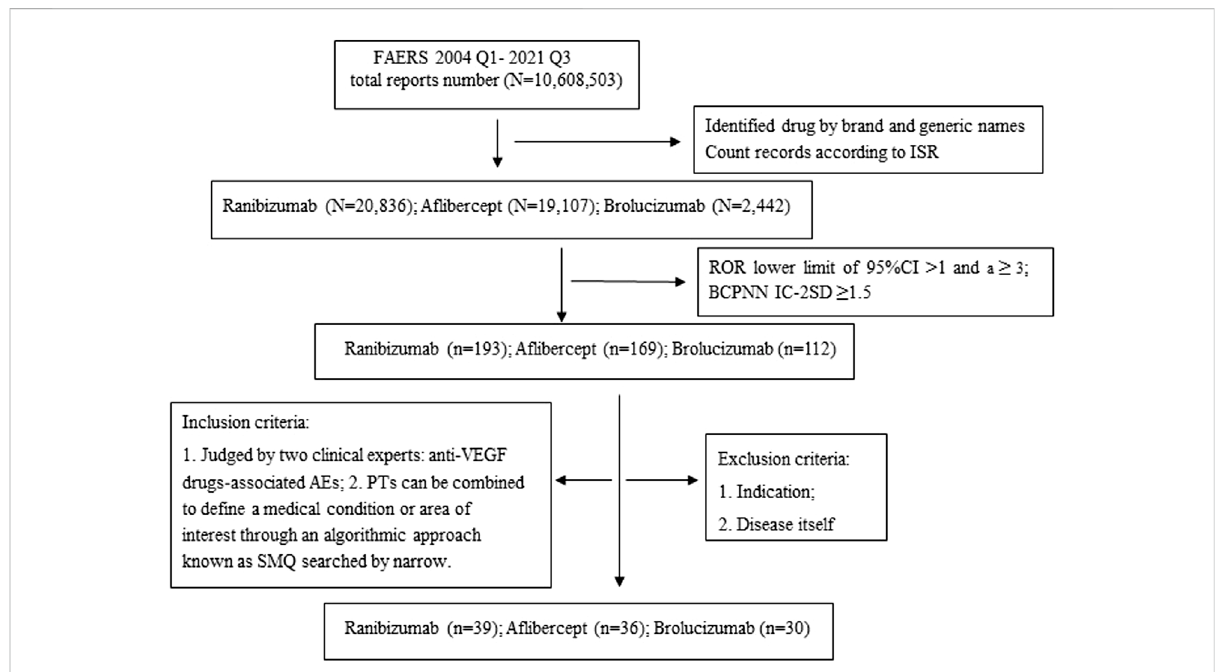
FIGURE 1 The work fl ow of data mining. Abbreviations: N, Total number of adverse drug events; n, Safety signals; ISR, Number that uniquely identi fi es an AERS report; PTs, Preferred Terms; SMQ, Standardized MedDRA